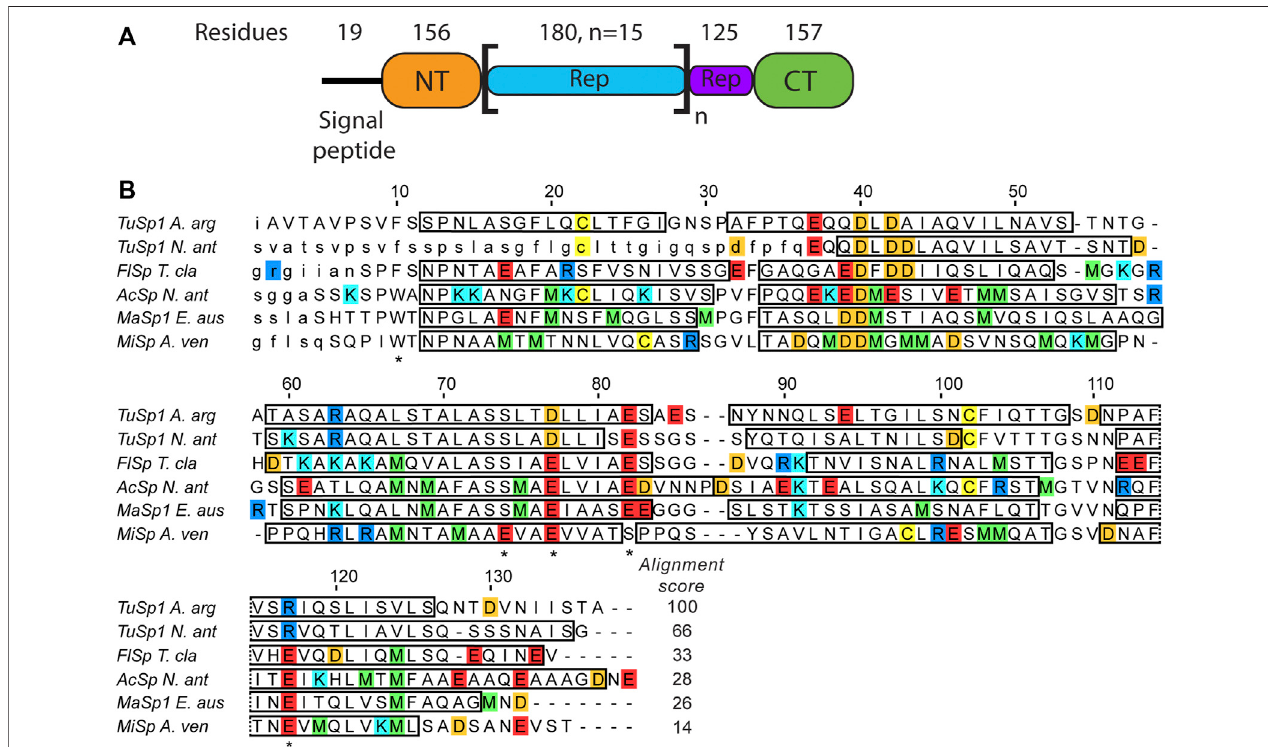
FIGURE 1 | (A) Argiope argentata TuSp domain architecture (Chaw et al., 2018). The number of residues for NT is different from the construct used in this study becauseitincludes ~20non-conservedresidueslinkingittotheRepregion. (B) AminoacidsequencealignmentofspidroinNTswithknowntertiarystructures.Included areNTsfrom Argiopeargentata TuSp(PDBID6TV5), Nephilaantipodiana TuSp(PDBID2K3Q), Nephilaclavipes FlSp(PDBID7A0O), Nephilaantipodiana AcSp(PDBID 7BUT), Euprosthenopsaustralis MaSp(PDBID2LTH)and Araneusventricosus MiSp(PDBID2MX9).Locationsof α -helicesareindicatedbyrectanglesandamino acidsexcludedfrom theexpression vector arein small caps.Residues protonated upon dimer formation(E79, E84,E119 in MaSp and inMiSp E73, E79 and E119) and W10/F10 aremarkedwithanasteriskbelowthesequence.Arginines areblue,lysinesarecyan,glutamicacidsarered,asparticacidsareorange, methionines aregreen and cysteines are yellow. ClustalW alignment score to E. australis MaSp NT is shown at the end of each sequence.